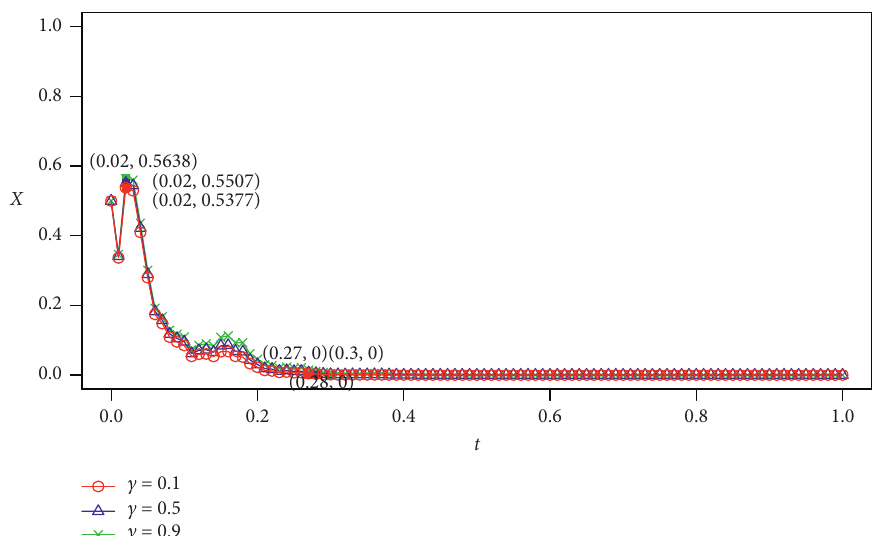
Figure 3: The impact of the degree of financial subsidies c on local government’s strategy selection.